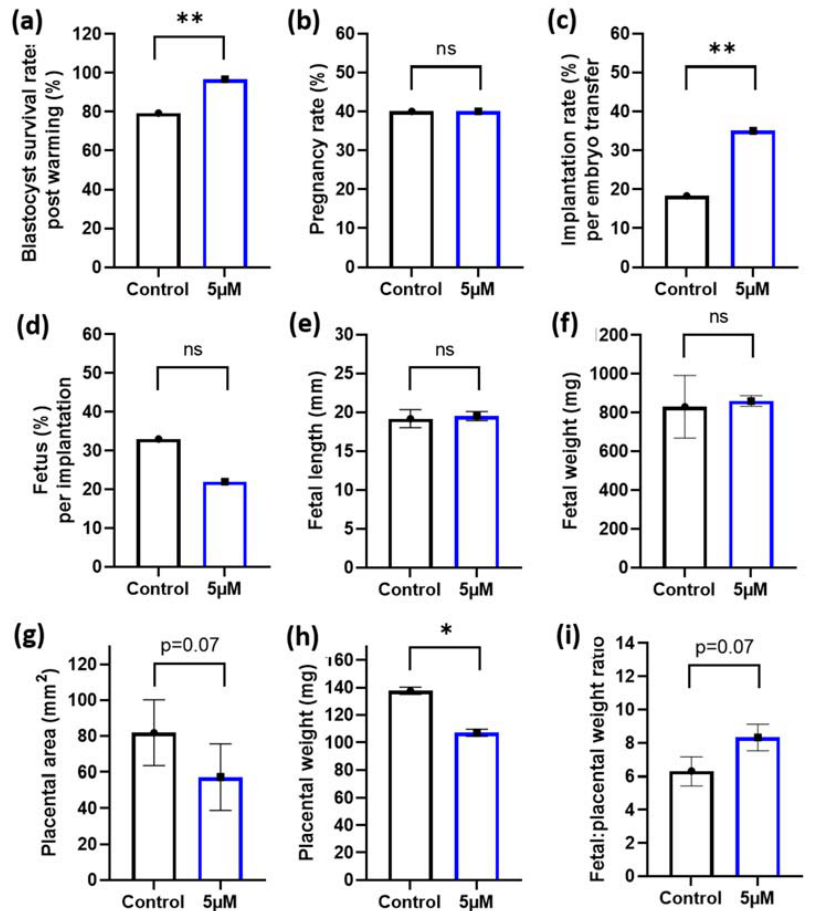
Figure 3. 5 µ M idebenone in vitro to sperm prior to IVF increases blastocyst thaw survival rates and implantation rates following embryo transfer. ( a ) Percentage of blastocyst that survived embryo thawing post embryo vitrification, ( b ) The percentage of pregnant mothers per embryo transfer, ( c ) The percentage of both resorptions and fetus per embryo transferred, ( d ) The percentage of fetus per implantation site, ( e ) Fetal lengths, ( f ) Fetal weights, ( g ) Placental area, ( h ) Placental weight and ( i ) Fetal placental weight ratios. Blastocyst thaw survival rates represents 92 blastocysts per treatment group. Embryo transfers and pregnancy data is representative of 60 blastocyst per treatment group from 6 male biological replicates transferred into 10 recipient mothers (6 blastocyst per treatment group per uterine horn). Blastocyst cryosurvivals were analyzed by a General Linear Model (GLM), with both treatment group and male fitted as fixed effects and warming day fitted as a covariate. Embryo transfer data and fetal outcomes were analyzed by a univariate GLM, with mother included as a random effect to control for variations to fetal outcomes induced by the mother: 5 μ M—5 μ M idebenone, ns—not significant. * p < 0.05, ** p < 0.01.